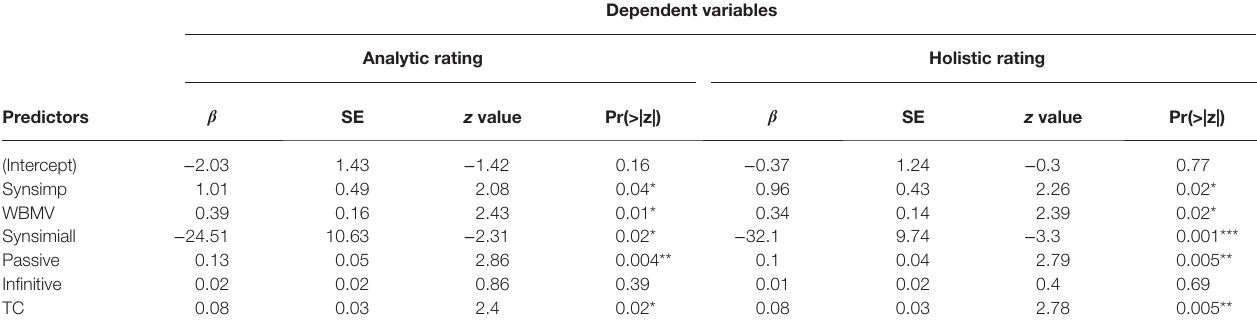
TABLE 5 | Variables in the equations of the logistic